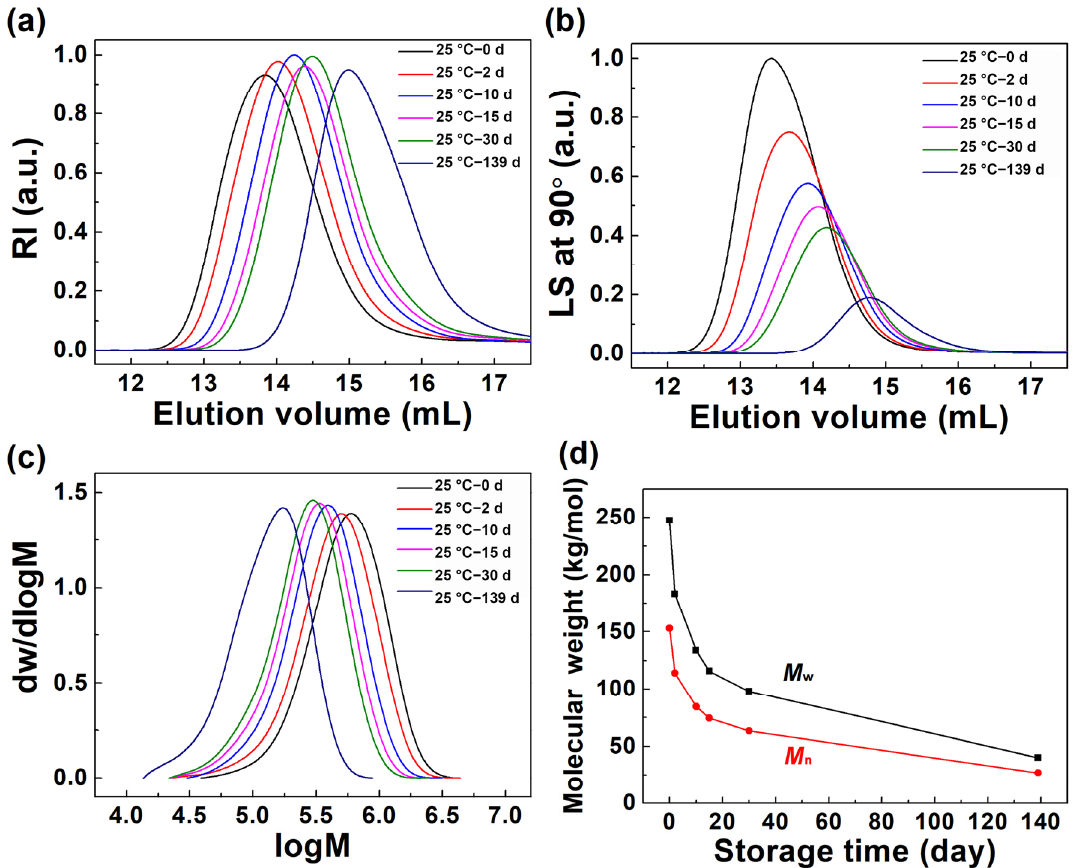
Figure 5. ( a ) RI and ( b ) LS at 90° signals as a function of elution volume, ( c ) molecular weight distribution curves, and ( d ) variation of M w and M n with storage time for PAA stored at 25 °C. The label 25 °C-0 d represents the original PAA solution, while 25 °C-2 d represents that it was stored at 25 °C for 2 days. Table 5. Molecular parameters of (6FDA-DMB) PAA in a concentrated solution stored at 25 °C for different times, measured by GPC-RI-MALLS-VIS.